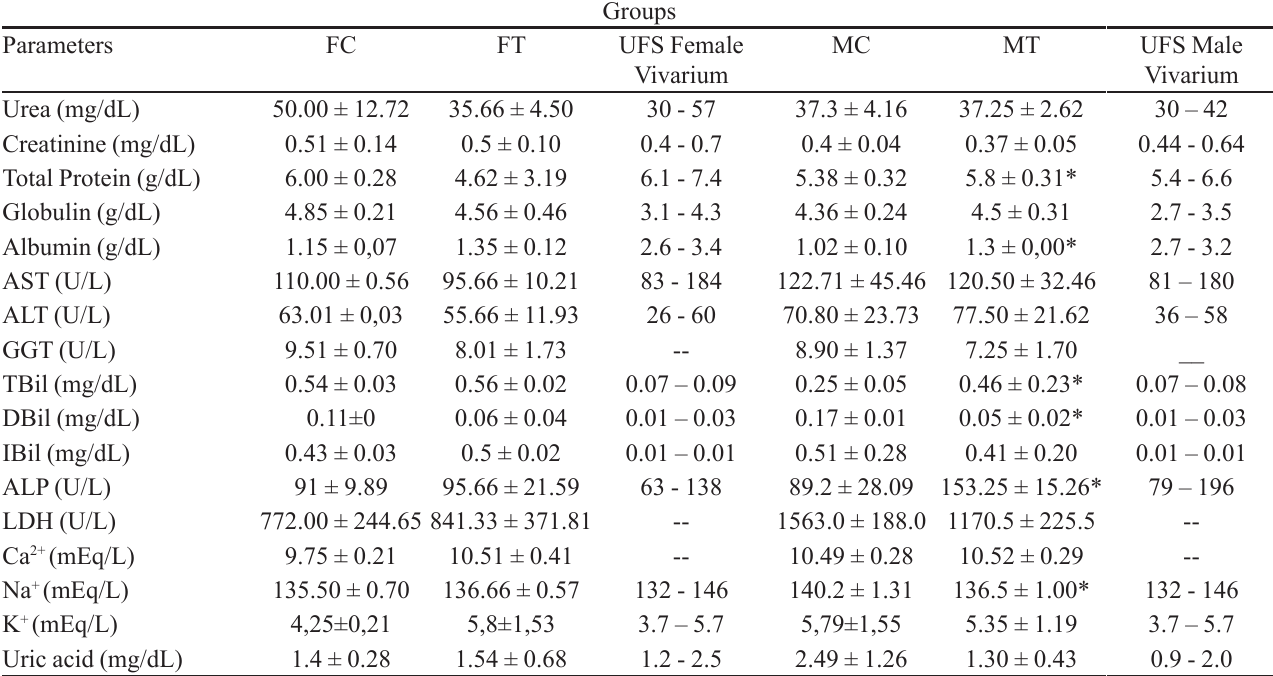
TABLE VII - Serum biochemical findings in rats treated with atranorin (ATR) at a single dose (5 g/kg)